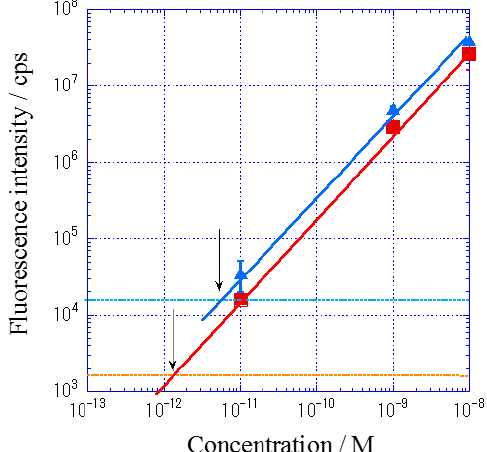
Figure 6. Calibration curve for Cy5-streptavidin (Cy5-SA): blue line shows the plots for IAS system and red line shows those for DAS system. Two broken lines with blue and red correspond to the standard deviation of background for IAS and DAS, respectively.